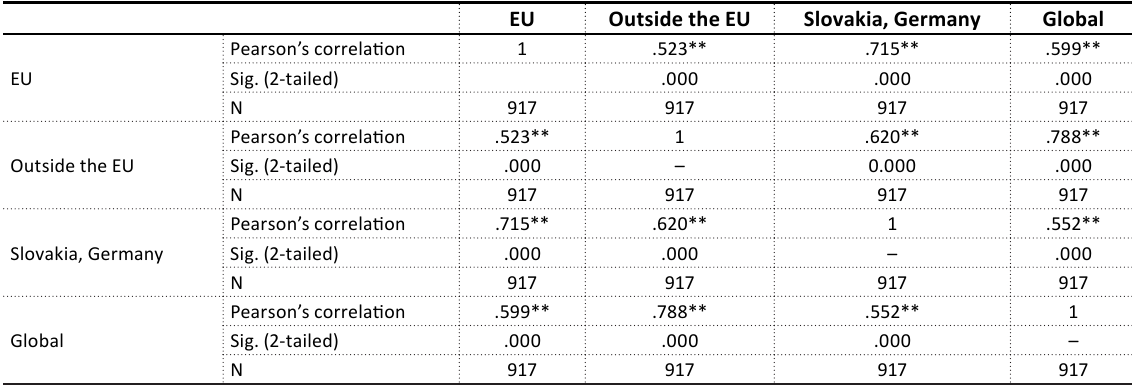
Table 3. Correlation analysis of variables: diversification of export territories